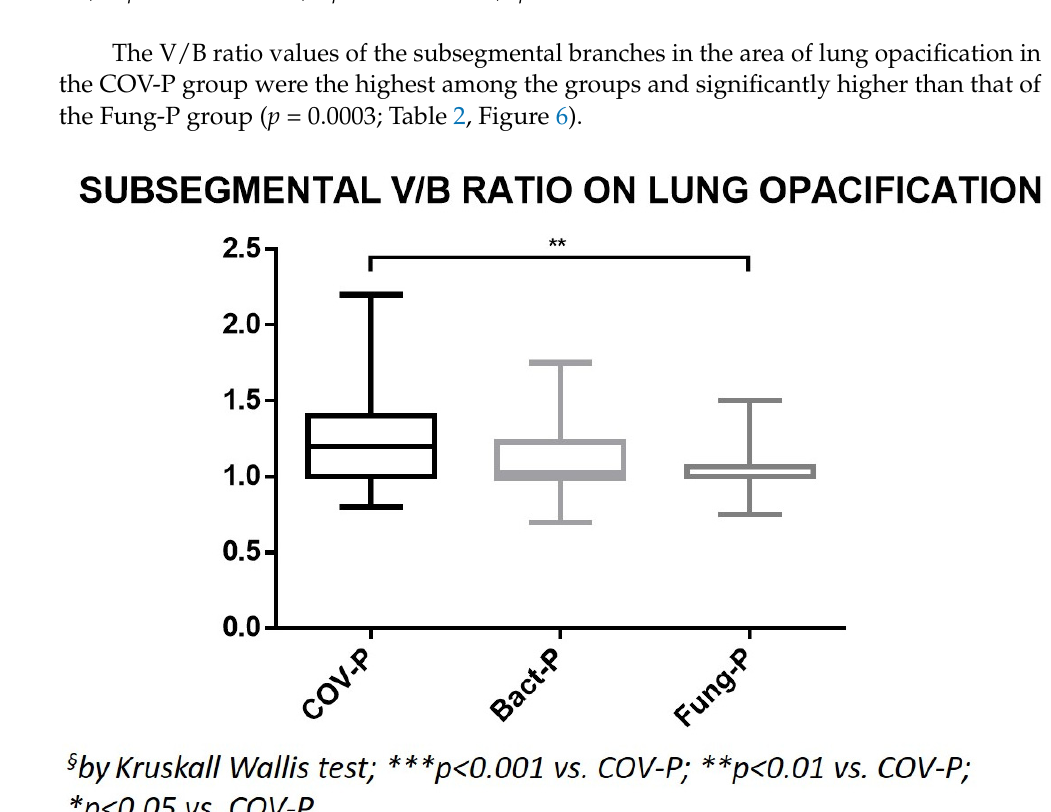
Figure 6. Ratio between the caliber of the subsegmental branches of the pulmonary arteries and their corresponding bronchial branches, measured on lung opacification. COV-P, COVID-19 pneumonia; Bact-P, bacterial pneumonia; Fung-P, fungal pneumonia.